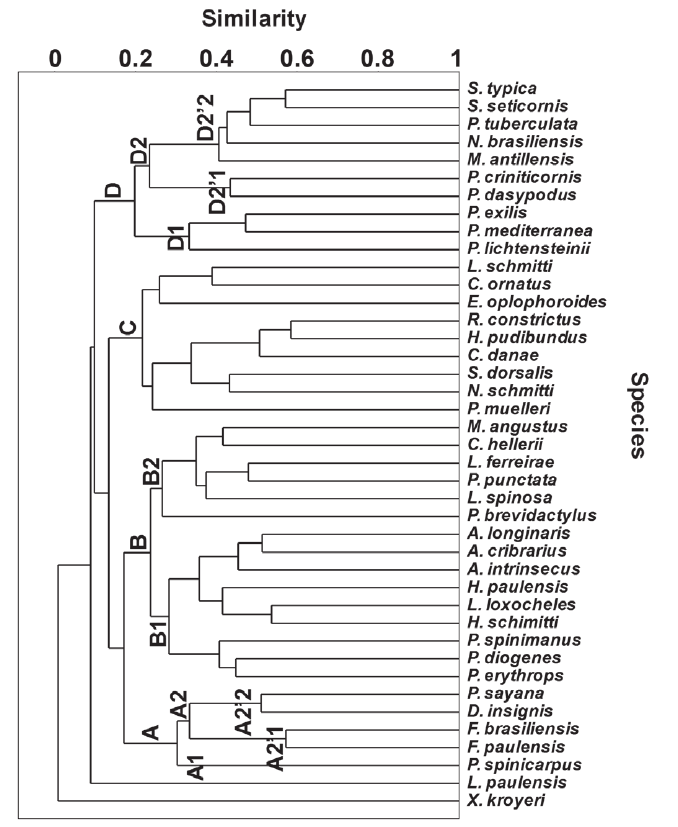
Fig. 3 - Grouping dendrogram (UPGMA) for the species captured during the study period (January 1998 through December 1999) in the Ubatuba